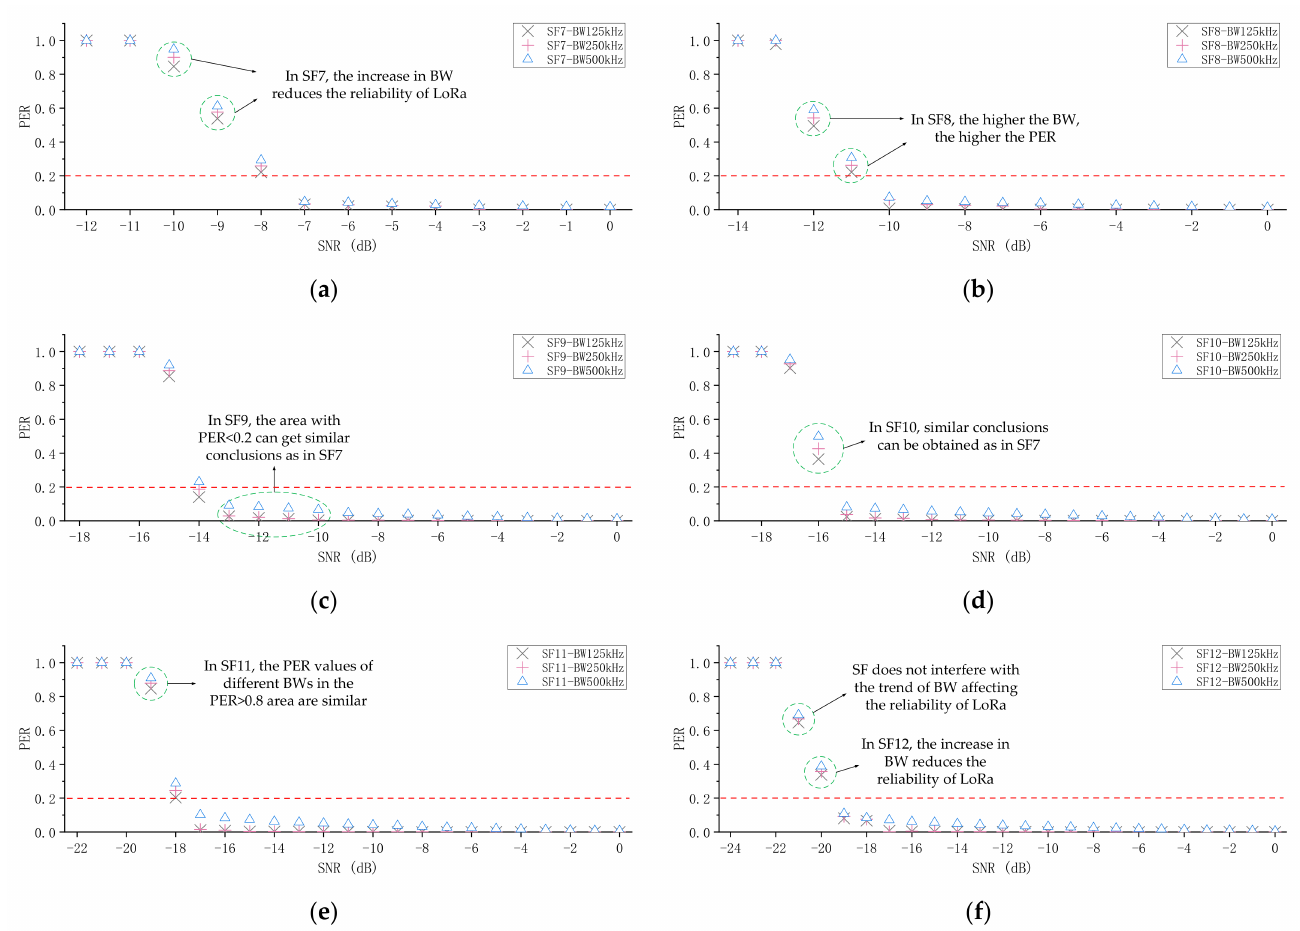
Figure 7. The measurement results of the influence of different BWs on the packet reception performance of LoRa when keeping the SF unchanged. ( a – f ) shows the PER for different